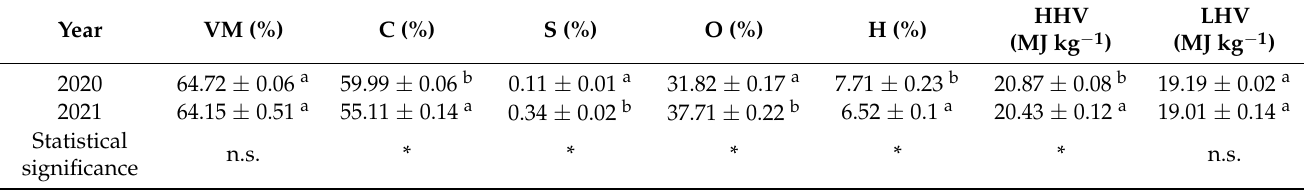
Table 1. Content of combustible substances in hazelnut shell in natural samples.